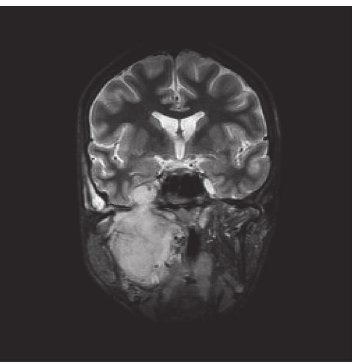
Figure 2: MRI (coronal view) showed the tumor in the right in- fratemporal fossa with intracranial extension and invasion of the maxillary sinus and mandible.